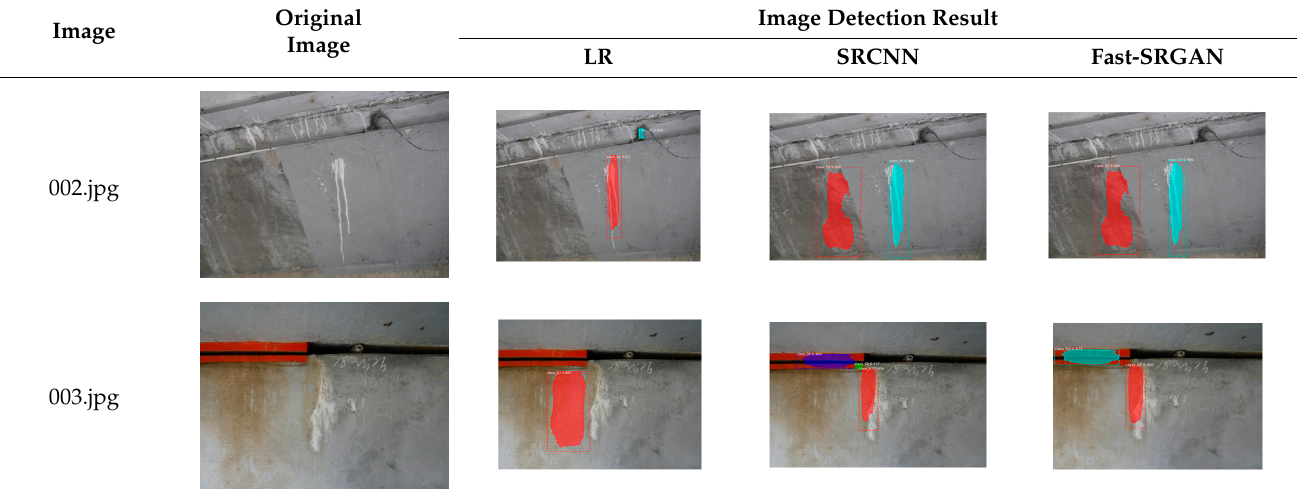
Table 5. Bridge damaged-object-detection result.